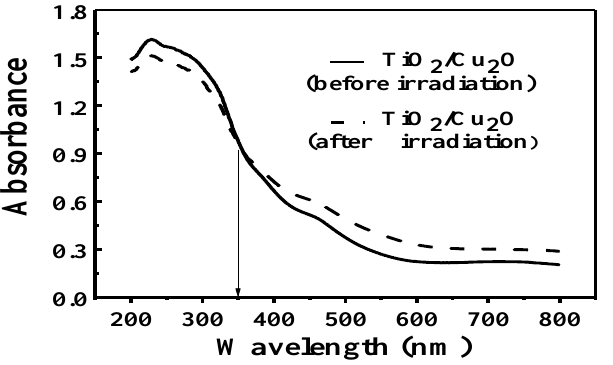
Figure 6. UV-vis diffuse reflectance spectra of TiO and after irradiation ( dashed line)